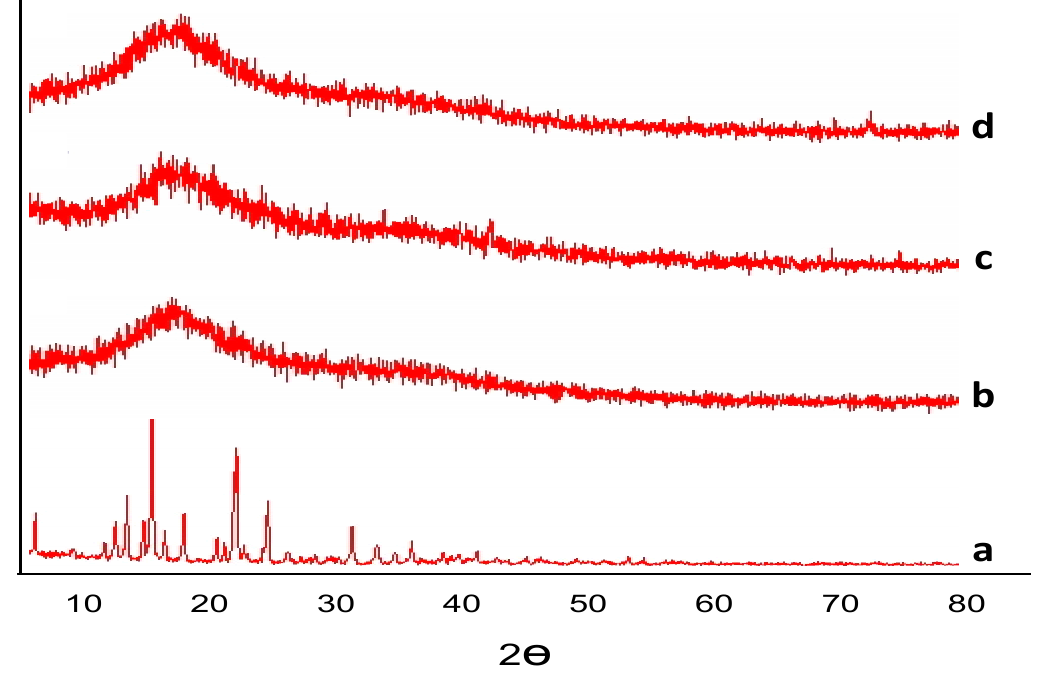
Figure 4. XRD of (a) captopril; (b) BSG-co-poly (AA)-unloaded hydrogel; (c) XRD of captopril (d); BSG-co-poly (AA)-loaded hydrogels.